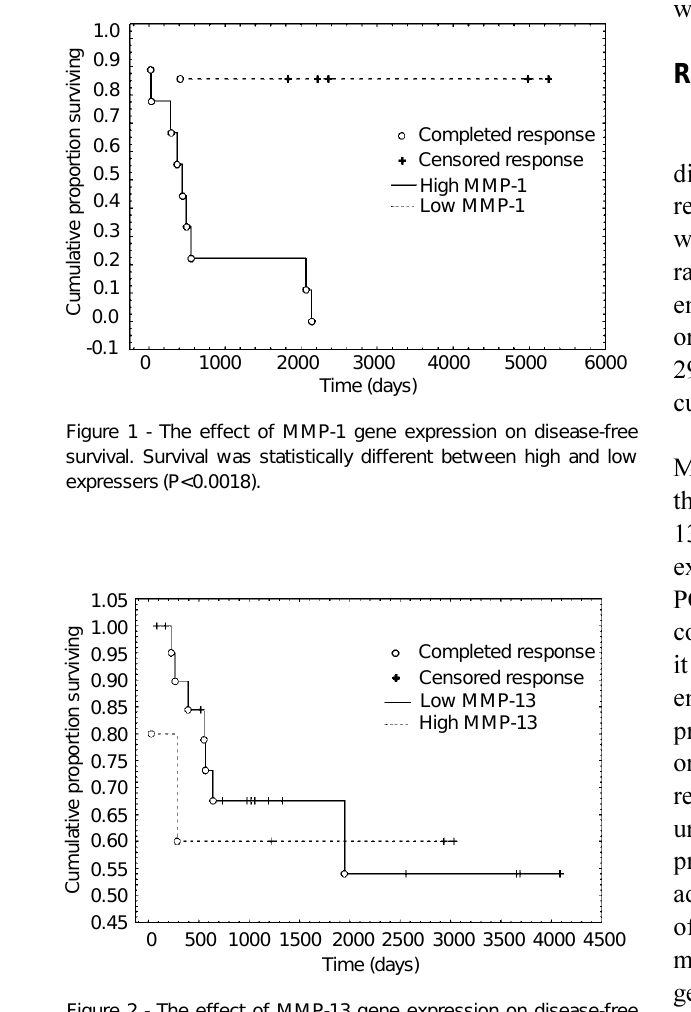
Figure 2 - The effect of MMP-13 gene expression on disease-free survival. Survival was not statistically different between high and low expressers (P